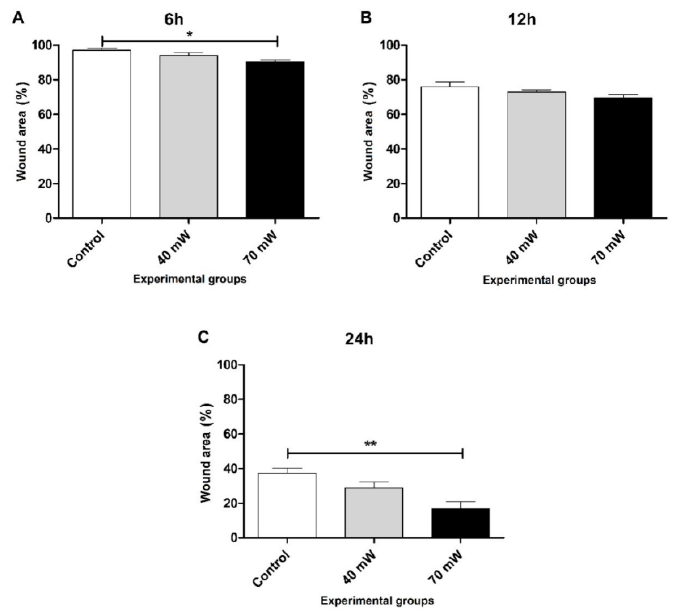
Figure 5. Wound area closure ( A ) 6 h, ( B ) 12 h, and ( C ) 24 h after to perform scratch wounds and the irradiation with LLL(ANOVA/Tukey); * p < 0.05 vs. control ** p < 0.01 vs.